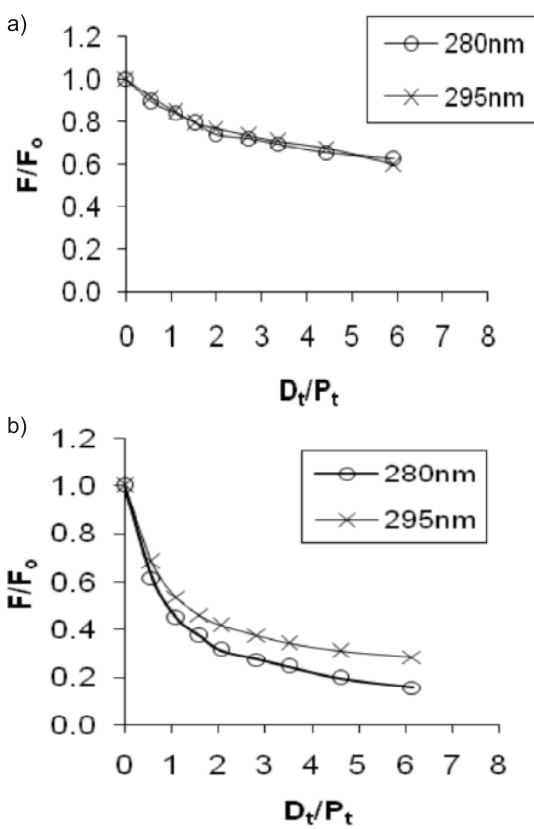
Figure 3. (a) Quenching of HSA fluorescence by glimepiride at excitation wavelengths of 280 and 295 nm. (b) Quenching of HSA fluorescence by glipizide at excitation wavelengths of 280 and 295 nm